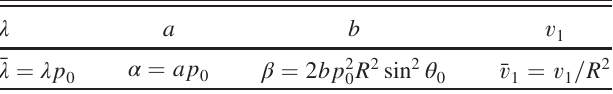
TABLE I. A summary of the parameter redefinitions in the